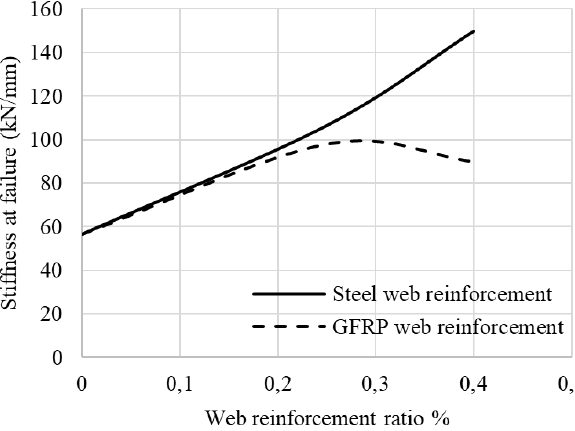
Figure 13: Relation between stiffness at failure and web reinforce- ment ratio